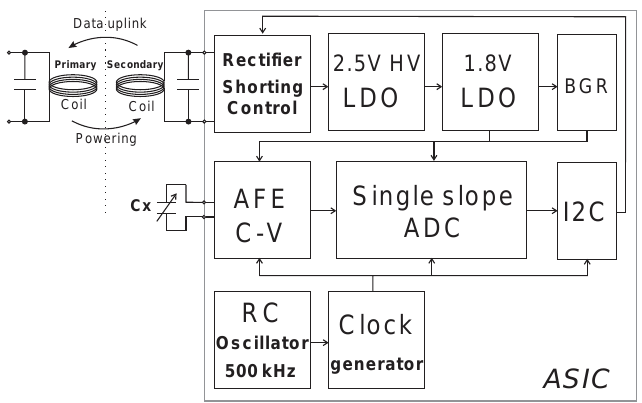
Figure 1. The system architecture of the capacitive pressure sensor interface showing the sense (Cx) capacitor.